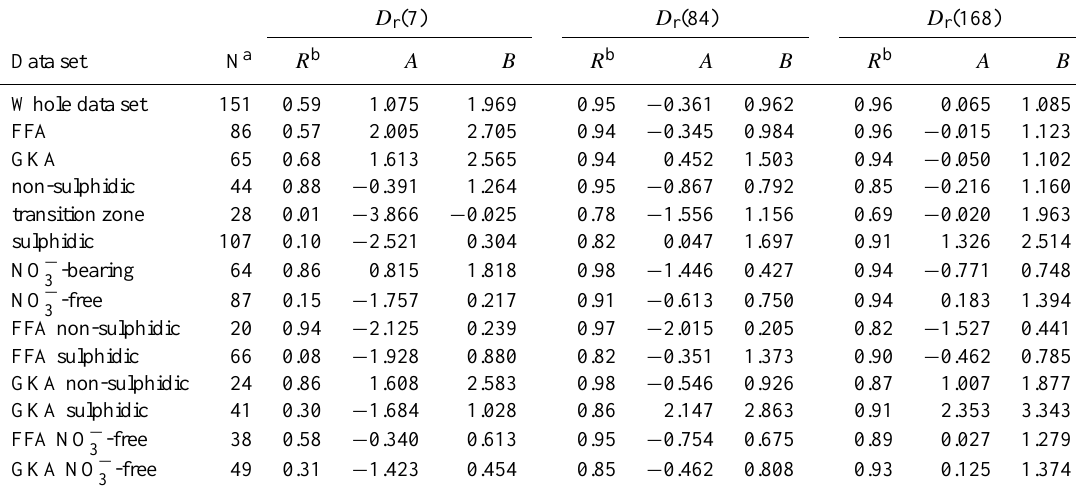
Table 4. Simple linear regressions between D cum (365) and D r (t) , f B − C (D cum (365))= A + B × f B − C (D r (t))